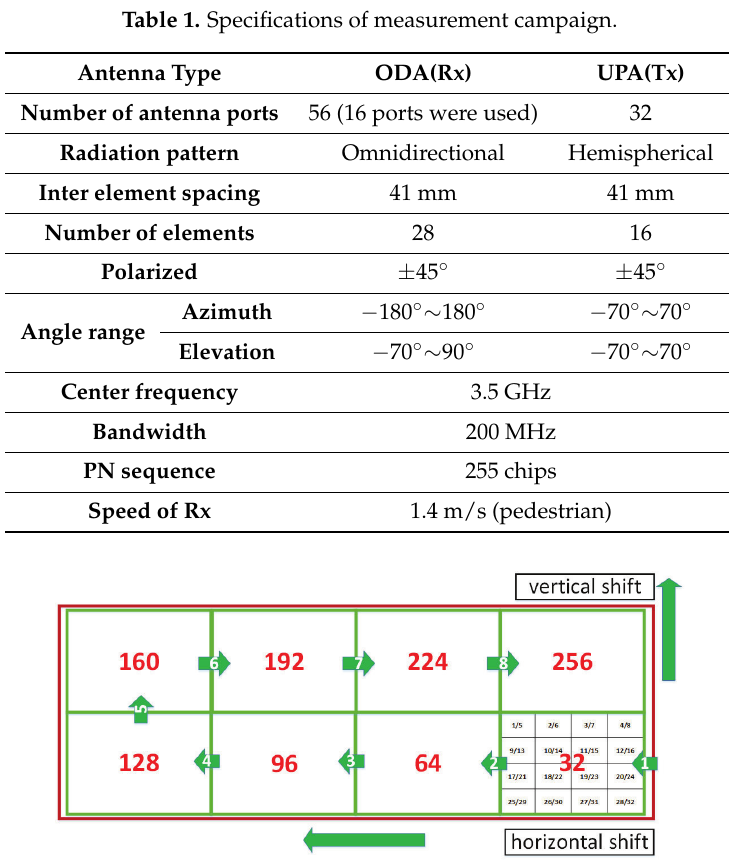
Figure 3. Scheme of antenna combining array in virtual